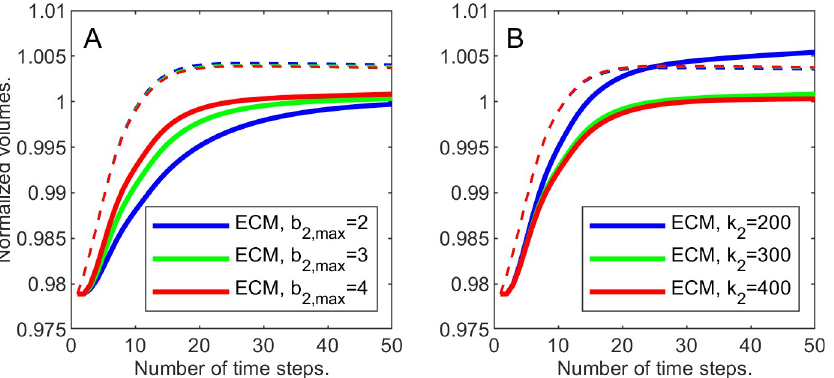
Fig 4. Cellular and ECM volume fractions changing with time. ECM—solid lines, cells—dashed lines. A: varying maximal rate of ECM growth, b 2,max ; B: Varying ECM strain parameter k 2 .